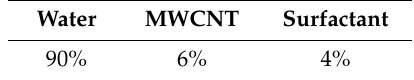
Table 3. Physical properties of MWCNTs.